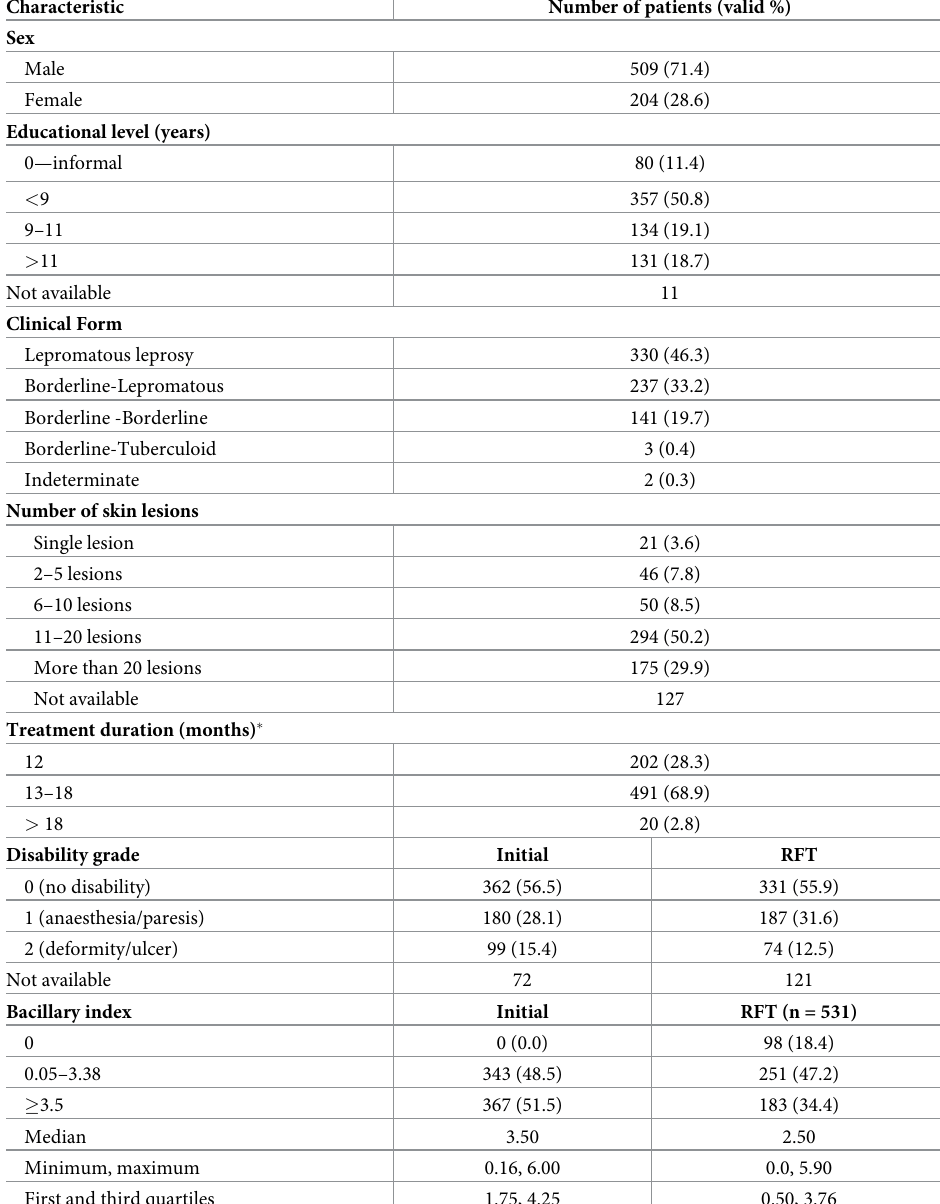
Table 1. Epidemiological and clinical characteristics at diagnosis of the 713-patient cohort treated with multiba- cillary multidrug therapy at Souza Arau´jo Outpatient Clinic, Fiocruz, during